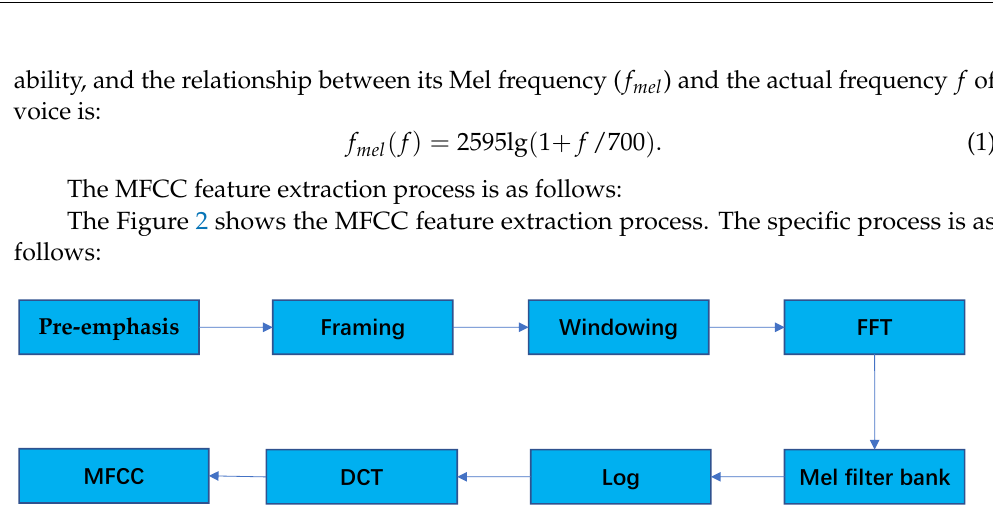
Figure 2. MFCC feature extraction process.